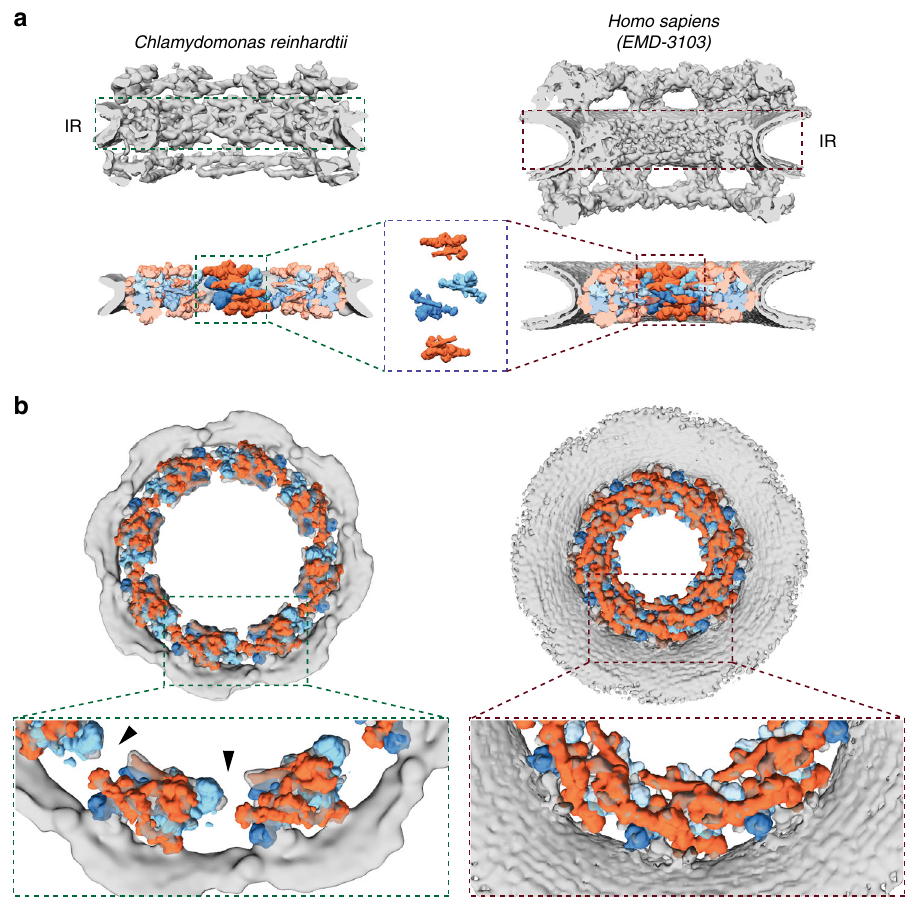
Fig. 2 The inner ring of the Cr NPC is dilated compared to the Hs NPC. a Structures of the Cr NPC and the Hs NPC, displayed as rendered isosurfaces, sliced through the central axis. The inner rings (IR) are indicated with dashed boxes (top). The four protomers of the asymmetric unit (orange: outer protomers, blue: inner protomers), each containing Nup93 and Nup62 subcomplexes, explain the inner ring densities of both the Cr NPC (bottom left) and Hs NPC (bottom right). b View of the Cr NPC and Hs NPC inner rings seen along the nucleocytoplasmic axis. The asymmetric units (spokes) of the Cr NPC inner ring are separated from each other (left), leaving relatively large peripheral channels (arrowheads) between the spokes, whereas the spokes of the Hs NPC are positioned closer together